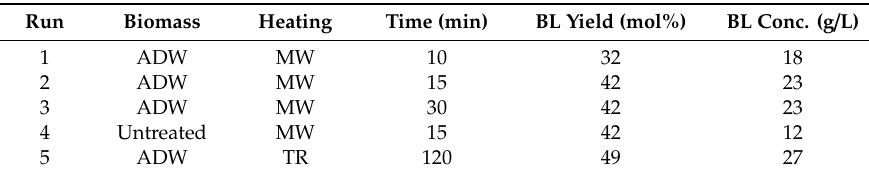
Table 1. One-pot butanolysis of the untreated or ADW Eucalyptus nitens to n -butyl levulinate (BL), adopting microwave (MW), or traditional (TR) heating. Reaction conditions: biomass loading 7 wt%, 190 ◦ C, H 2 SO 4 1.2 wt% .